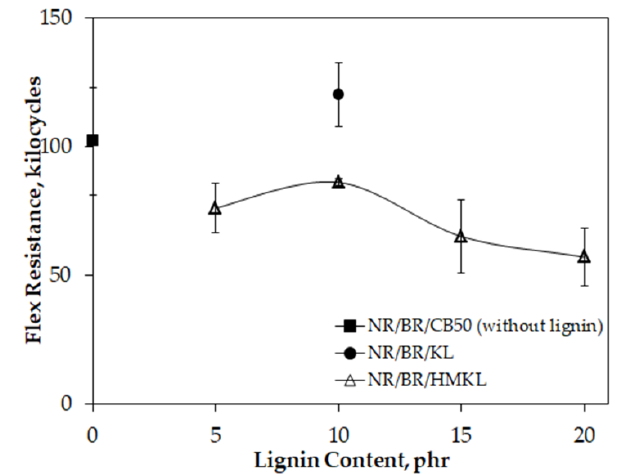
Figure 12. The effect of HMKL content on the flexing resistance of lignin-filled NR/BR compounds.